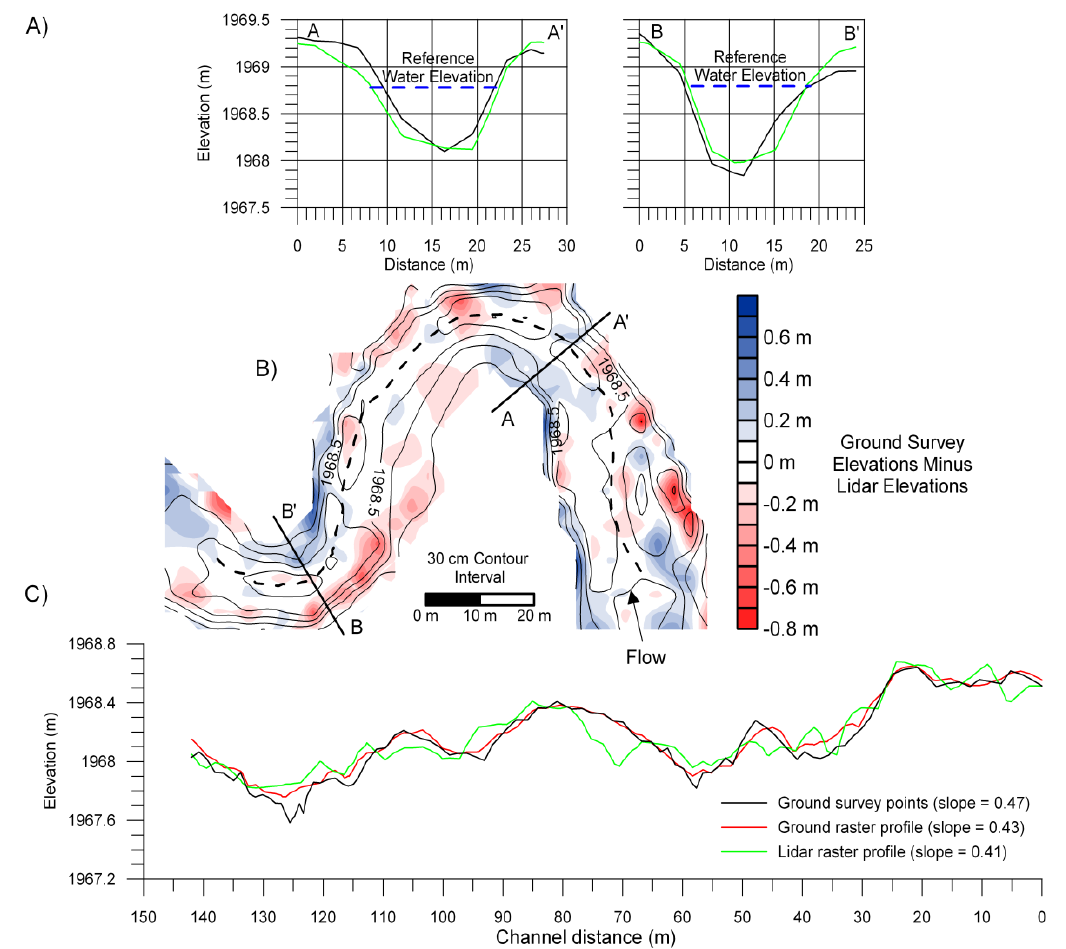
Figure 6. Bathymetric LIDAR and ground survey comparison at a meandering channel reach. (A) Example cross sections at locations shown in map view: black = ground survey, green = LIDAR survey; (B) Map view comparison. The contours are from ground survey data. The colored intervals are elevation differences calculated as ground survey grid node elevation minus LIDAR grid node elevation. These colored intervals are georeferenced to the contour map and show that the largest errors tend to occur along the stream banks. The dashed line is the location of channel elevation profile; (C) Channel elevation profiles: black = ground survey points (most accurate), red = profile through ground survey raster, green = profile through LIDAR